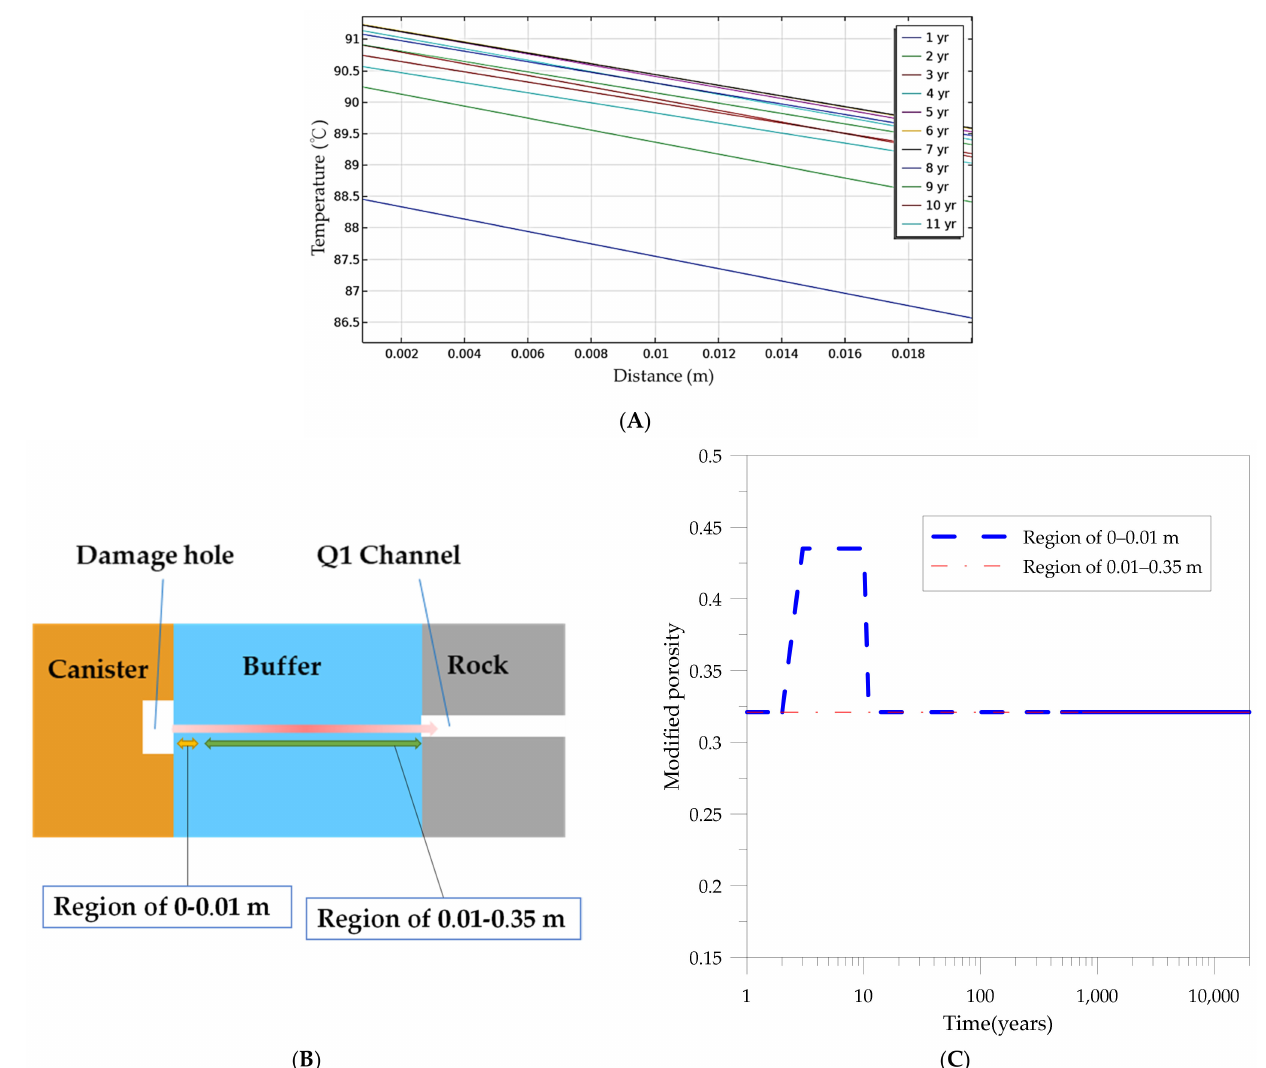
Figure 14. Schematic illustration of modified porosity setting in radionuclide transport model: ( A ) the temperature in relation to distance for the simulation from 1 year to 11 years; ( B ) schematic diagram of the buffer zone divided into two areas; ( C ) transient modified porosity distribution in buffer